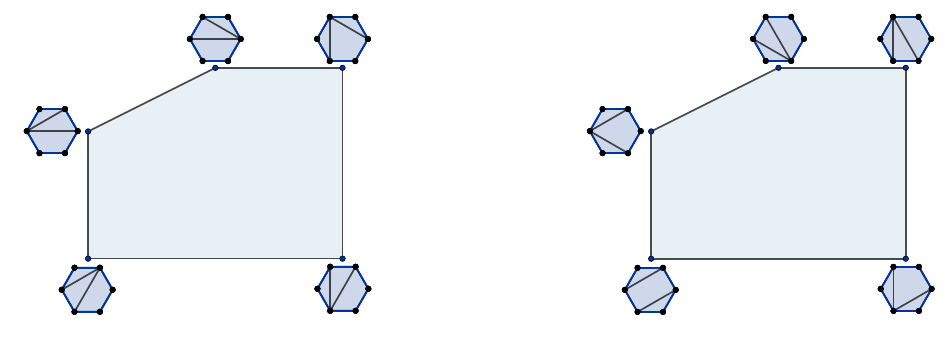
Figure 7 . Accordiohedron for dissection (13 , 14) . Figure 8 . Accordiohedron for dissection (13 , 15) .